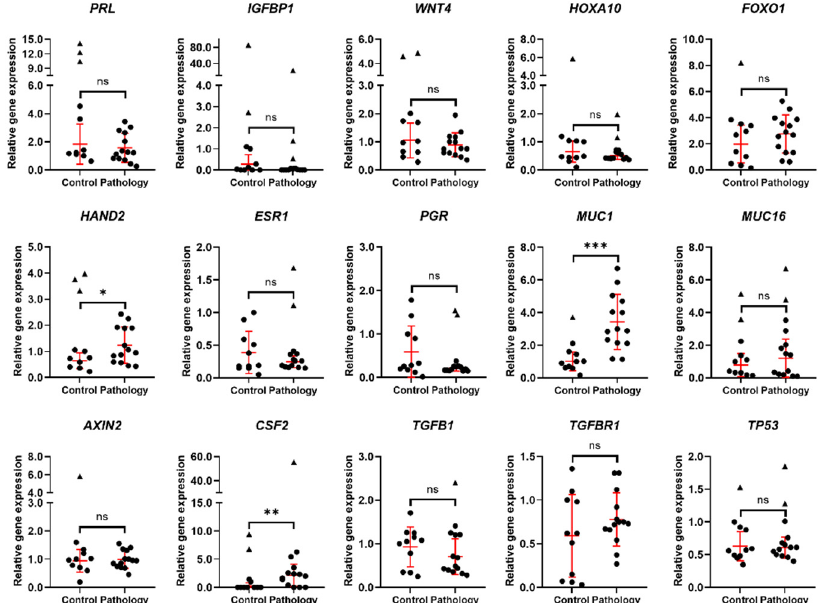
Figure 1. Expression of decidualization and implantation related genes. Results are presented as mean ± standard deviation (red lines), triangle data points represent outliers based on ROUT (Q = 5%). In the control group, n = 11; in the pathology group, n = 14. * p ≤ 0.05; ** p ≤ 0.01; *** p ≤ 0.001; ns—not statistically significant, based on the Mann–Whitney U test.